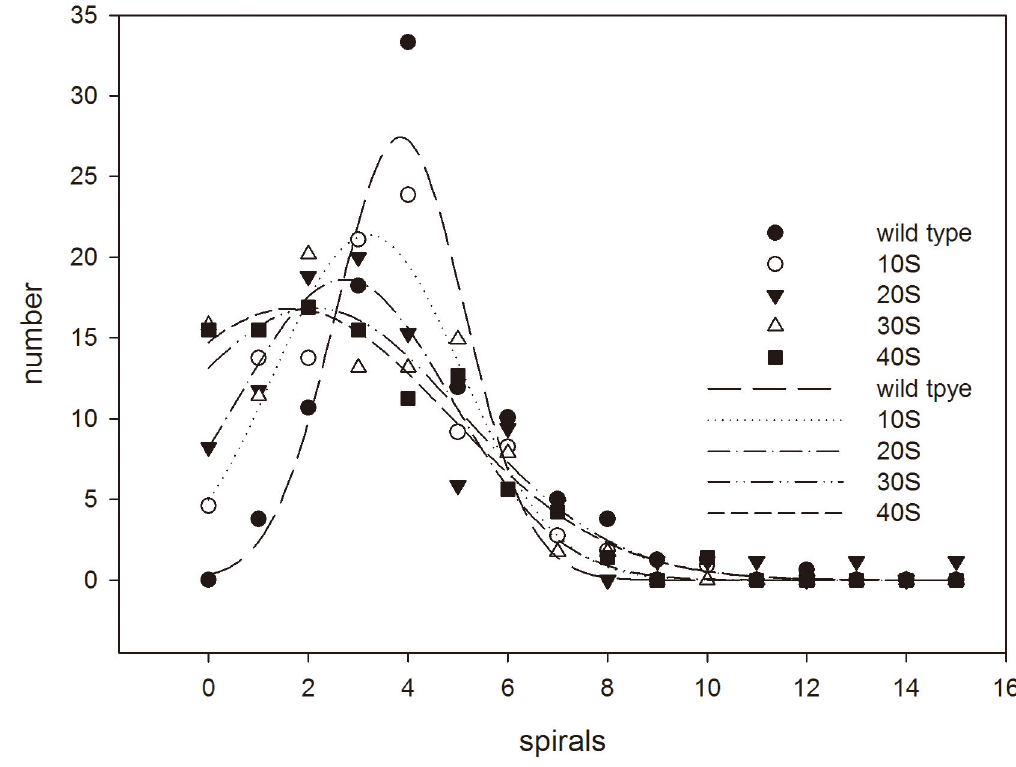
Figure 4. Change in the number distribution of S. platensis spirals with increase of ARTP mutagenesis dosage. In this figure, the length of S. platensis was calculated by spiral numbers in one filament. The number distribution of spirals during the ARTP treatment was regressed by Gaussian distribution, X : peak, R: Regression, SEE，Standard Error of Estimate (Table 3). 0